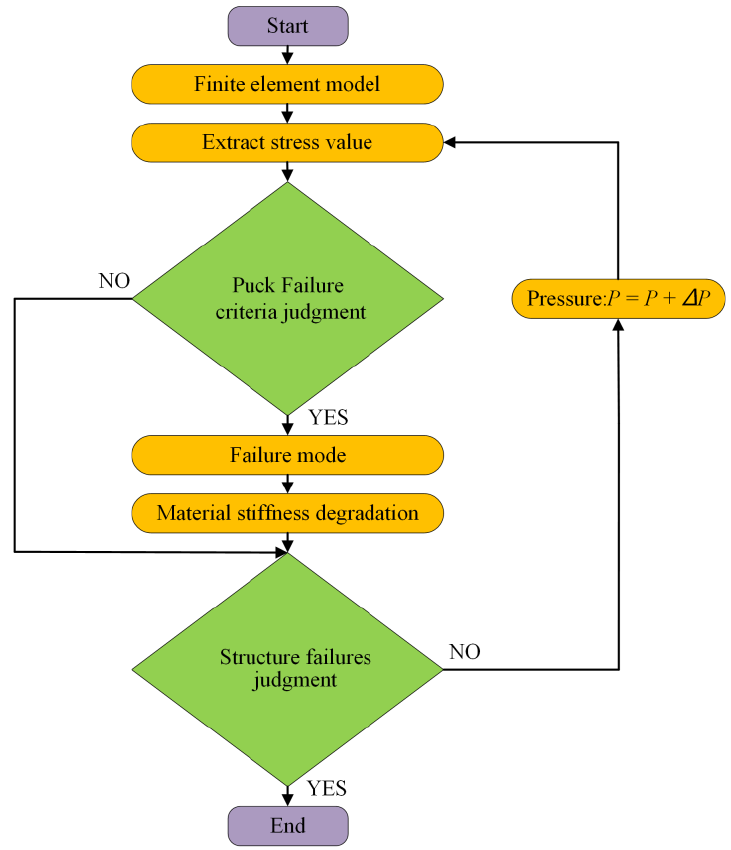
Figure 9. Flow chart of progressive damage process.